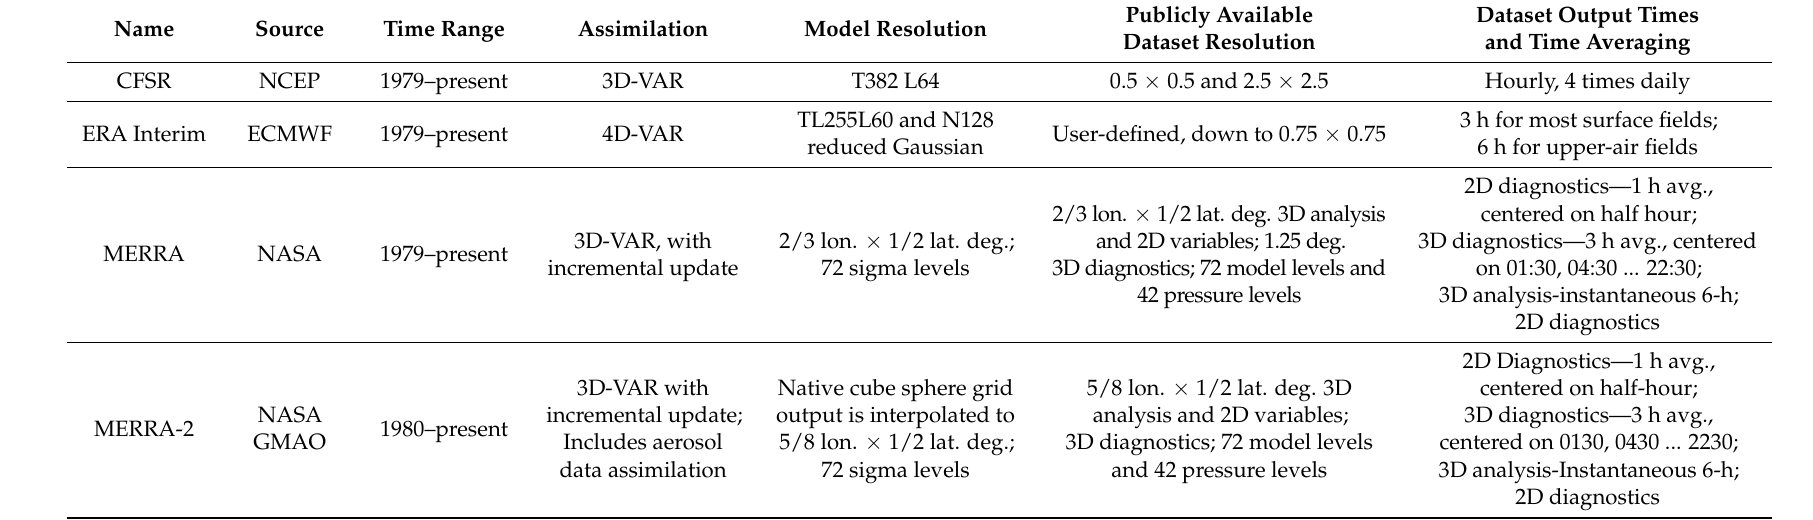
Table 1. Comparison of the third-generation reanalysis data.